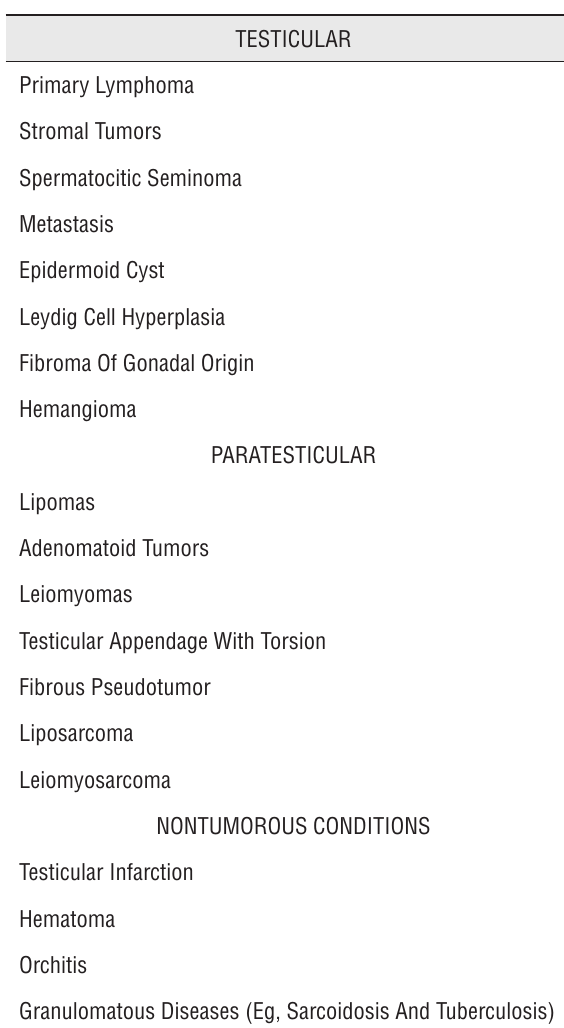
Table 1 – Scrotal masses in elderly men. Figure 1 – Epididymis (4x).